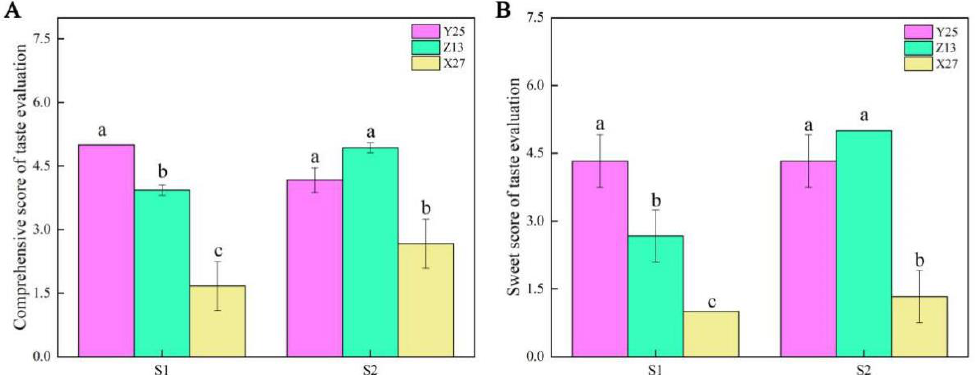
Figure 5. Comprehensive score and sweetness score of three sweetpotato cultivars in two growth stages. ( A ) The changes of comprehensive scores in taste evaluation of three sweetpotato cultivars; ( B ) The changes of sweet scores in taste evaluation of three sweetpotato cultivars. The SE of three biological repetitions is shown as an error bar. Bars not sharing a common letter differ ( p < 0.05) by one-way ANOVA and Tukey’s multiple comparison test.